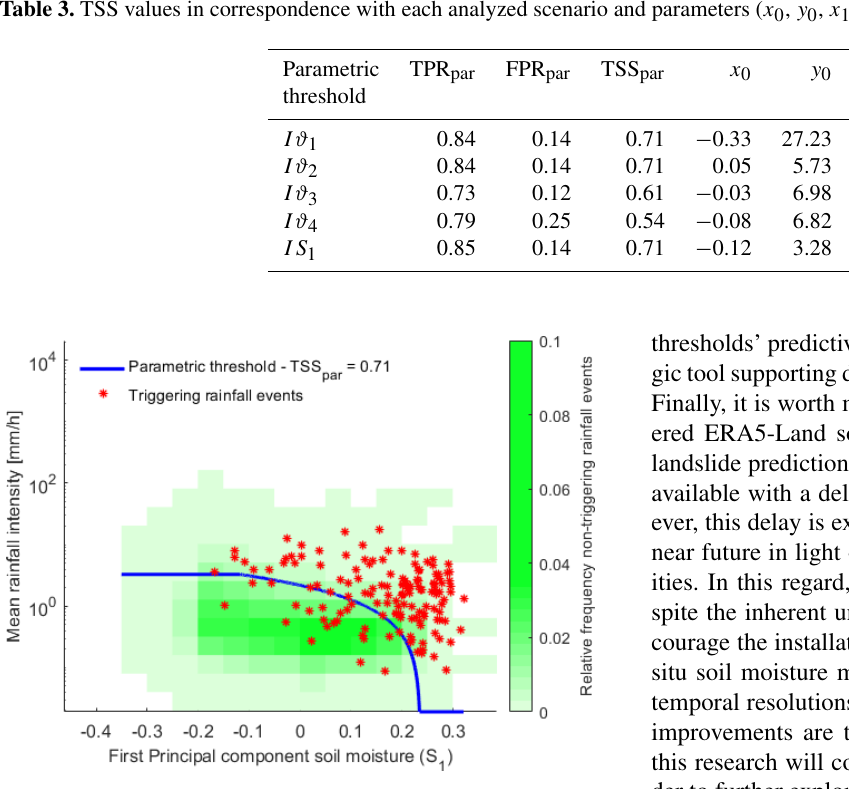
Figure 9. Parametric threshold on the semi-log plane between ob- served mean rainfall intensity ( I ) and first principal component of soil moisture ( S 1